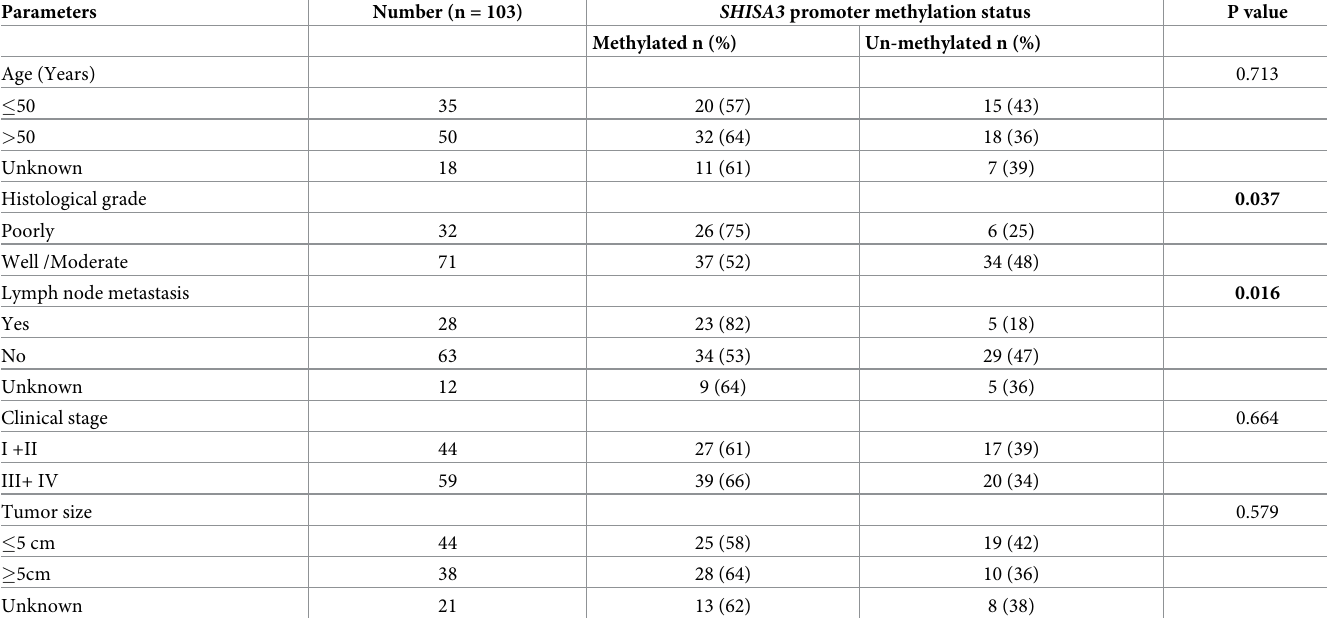
Table 2. Association between SHISA3 hypermethylation and clinicopathological parameters of breast cancer